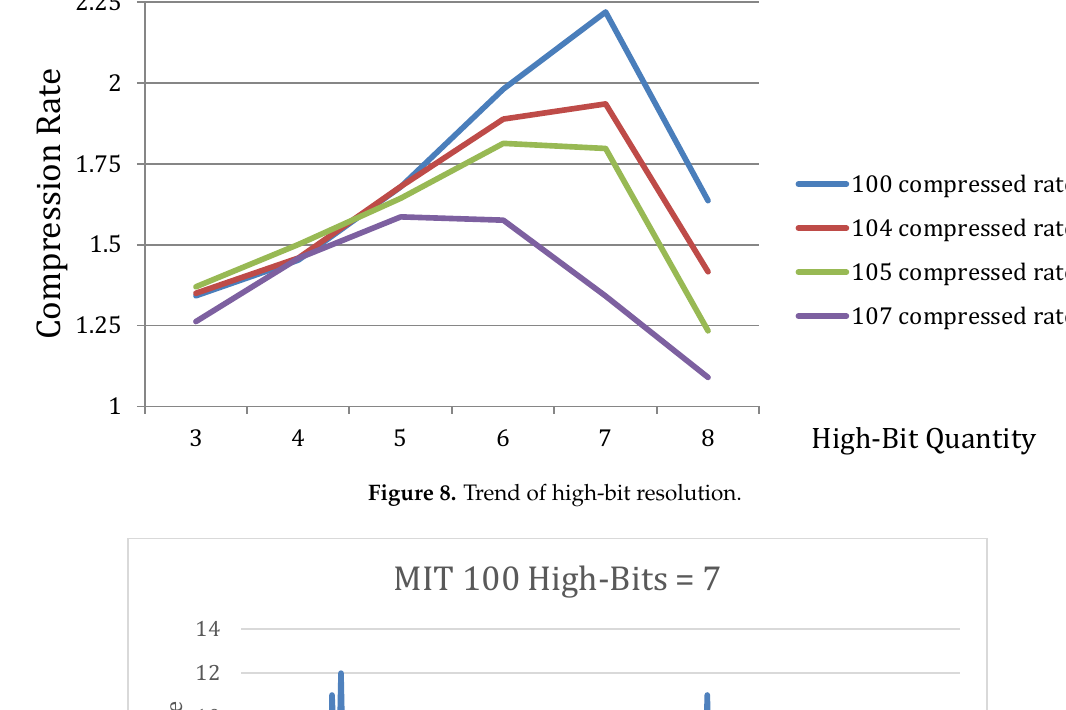
Figure 8. Trend of high-bit resolution.